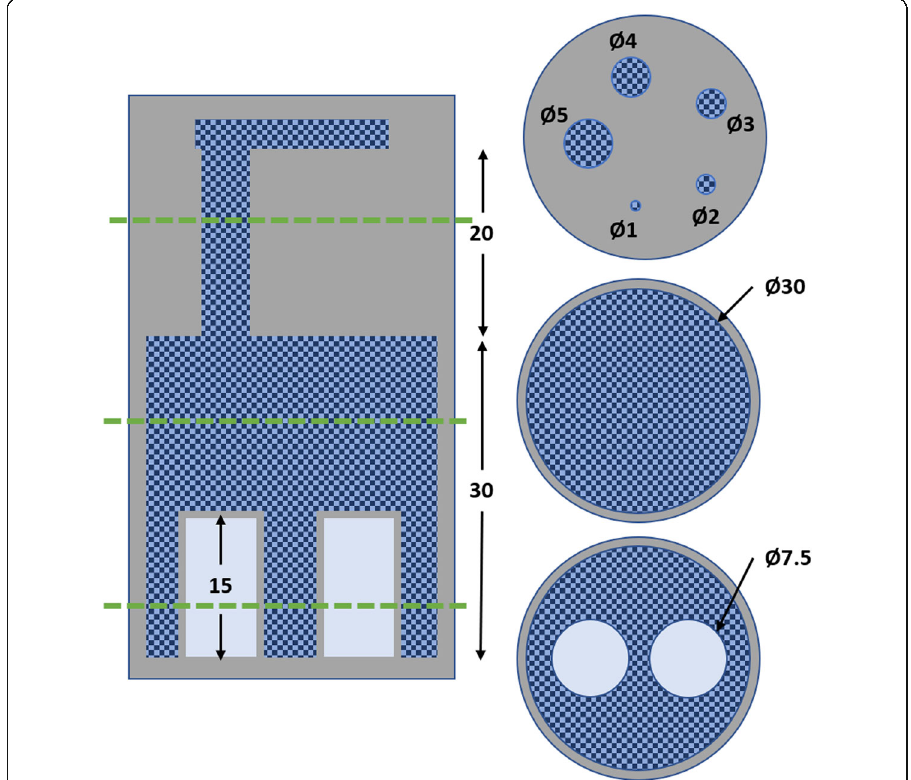
Fig. 1 Cross-sections of the NEMA image quality phantom with dimensions in mm. Left: axial cross-section. Right: transverse cross-sections of the three different regions. The grey area represents the PMMA phantom; the dark blue hashed region represents the volume filled with activity, and the light blue represents the cold air and water